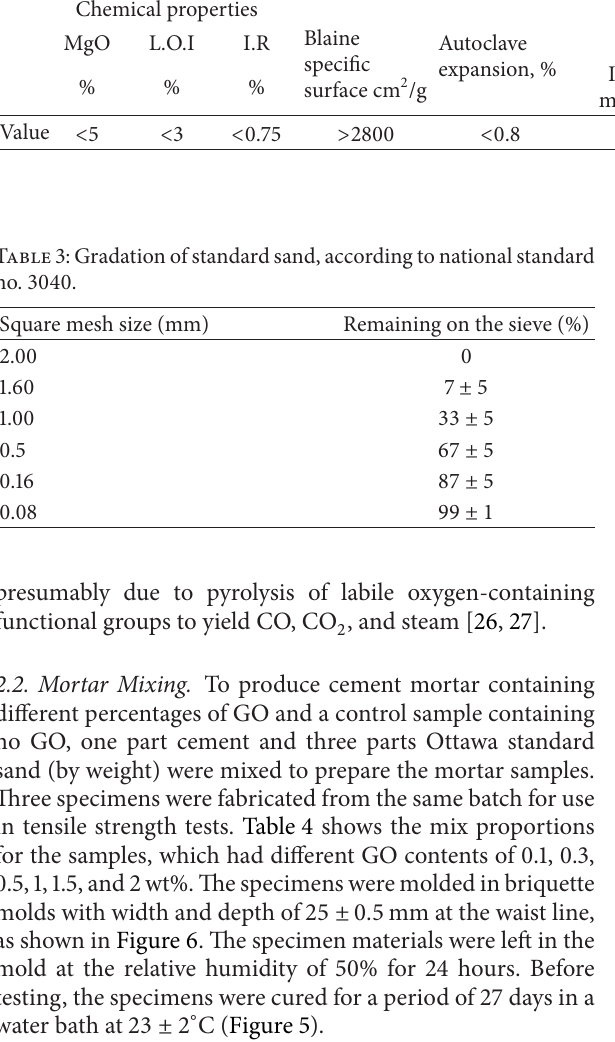
Table 2: Properties of type I cement type I, according to national standard no. 389 (Tehran Cement). Chemical properties